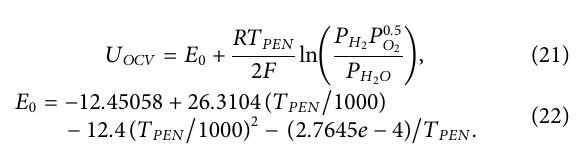
Frontiers in Energy Research |